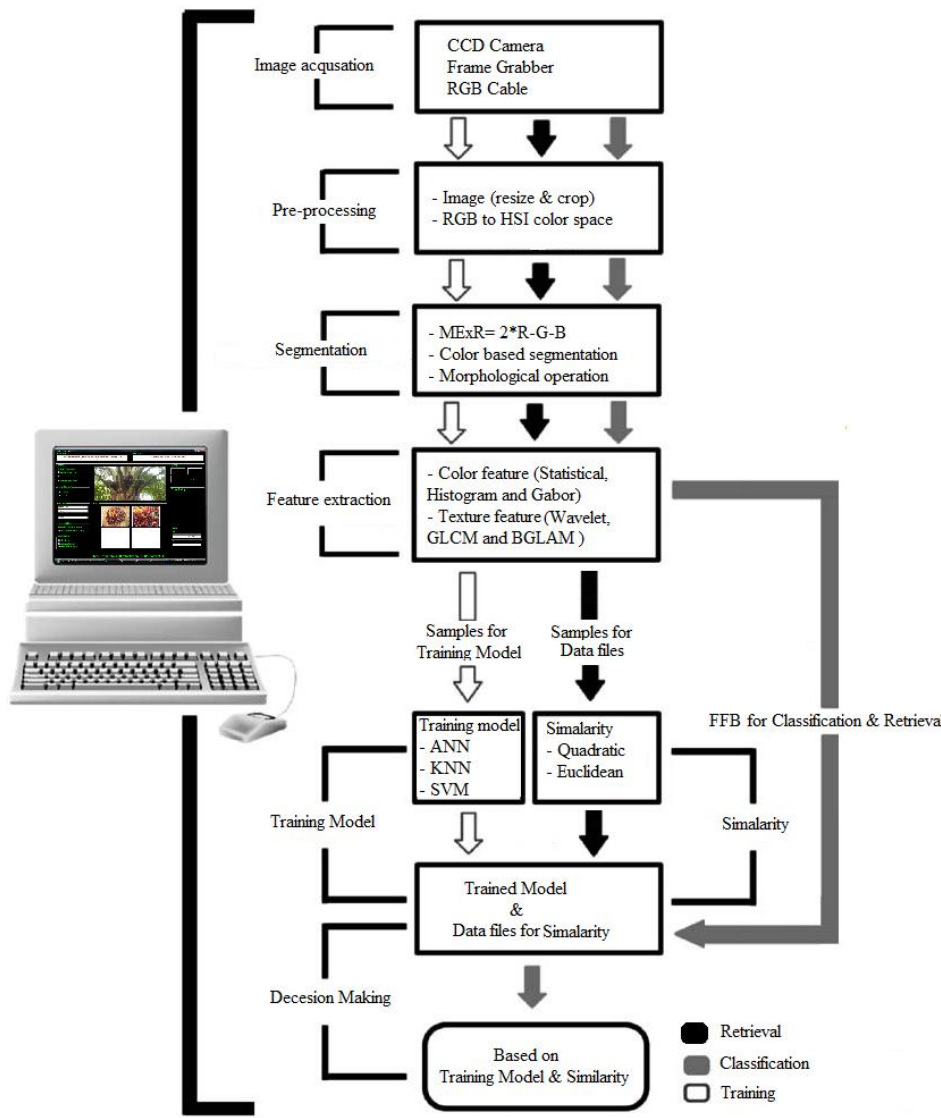
Figure 5. Steps and image processing techniques for the FFB real-time oil palm ripeness classifica- tion